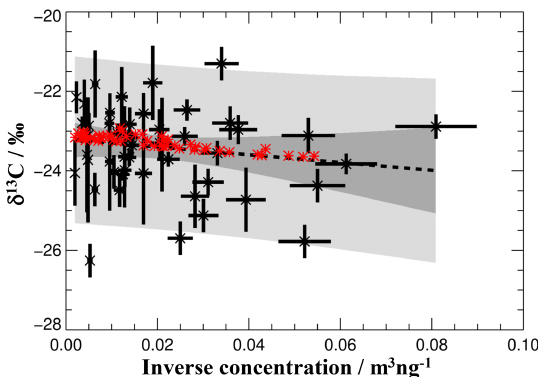
Figure 7. Keeling plot depicting the observed levoglucosan δ 13 C vs. the inverse concentration (black symbols). Model results are given (red symbols), as well as the line fitted to the experimental data (dashed). The light and dark grey shaded areas represent the 95% prediction and confidence intervals,